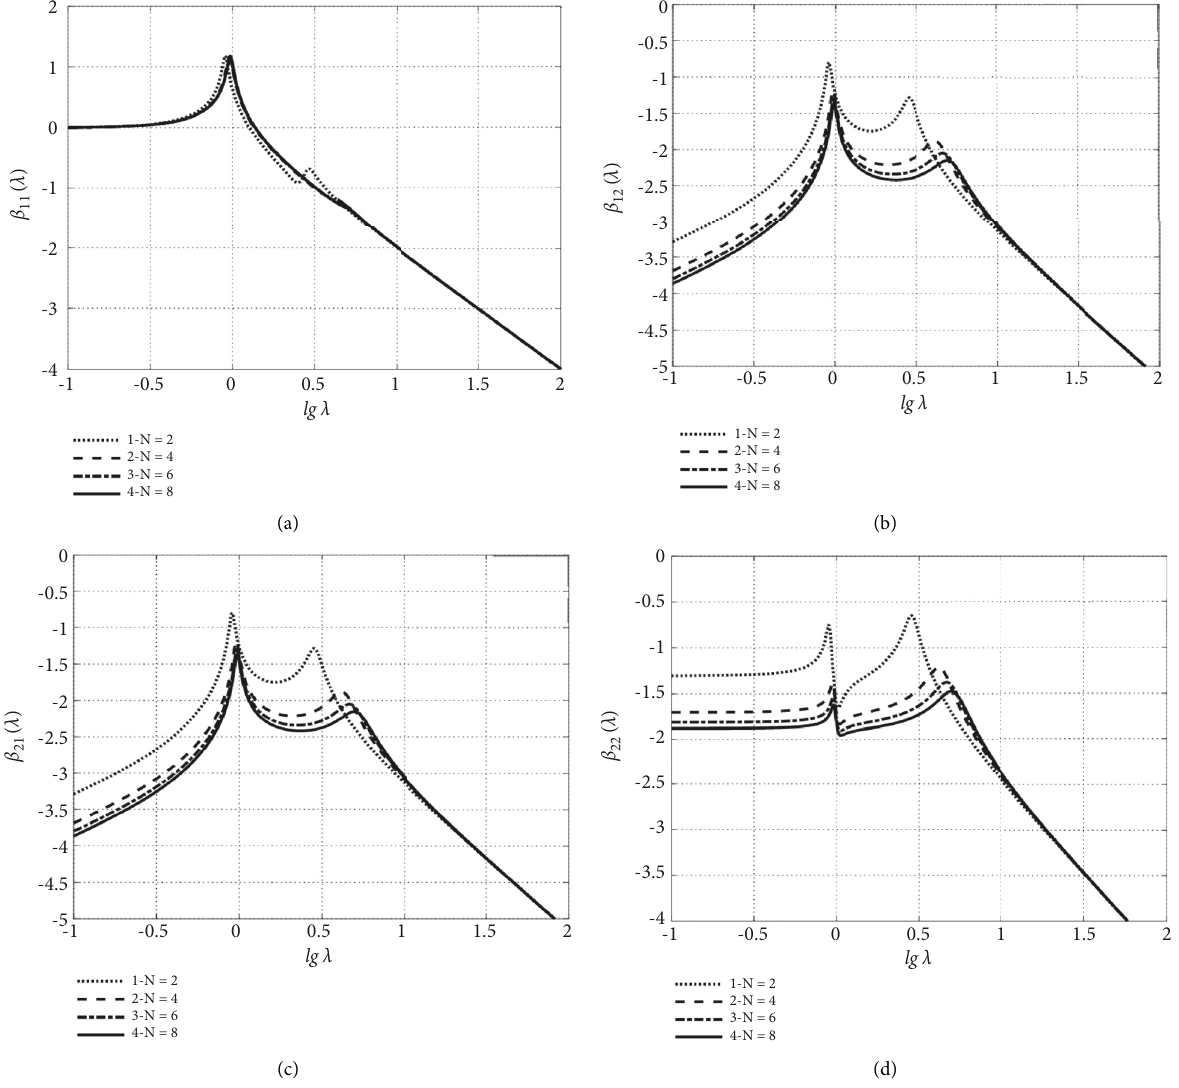
Figure 4: The variation law of the logarithmic dynamic amplification coefficient under different numbers of vibration isolators: (a) logarithmic dynamic amplification factor β 11 ,(b) logarithmic dynamic amplification factor β 12 , (c) logarithmic dynamic amplification factor β 21 , and (d) logarithmic dynamic amplification factor β